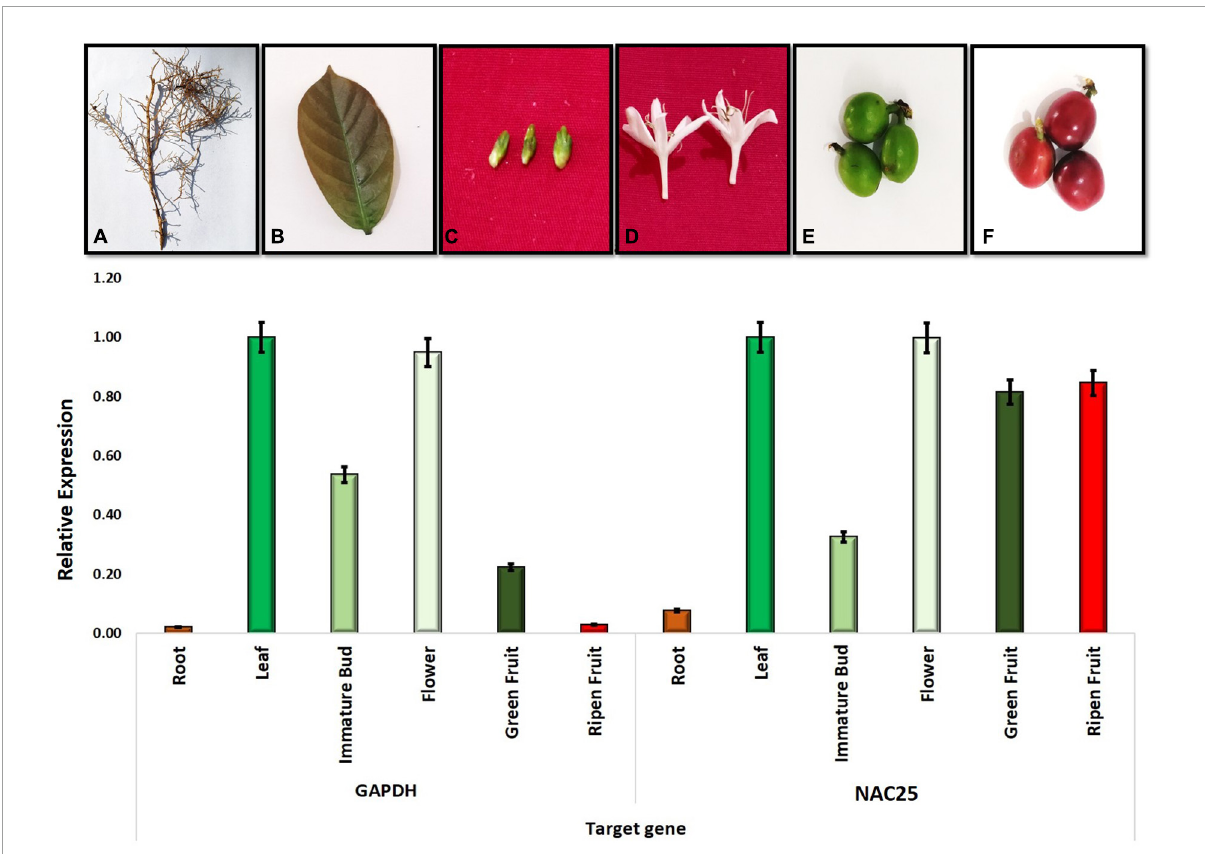
FIGURE6 Figure depicting the relative expression of NAC25 gene in different tissues of coffee (A) Root; (B) Leaf; (C) Immature Bud; (D) Flower; (E) Green fruit and (F) Ripen